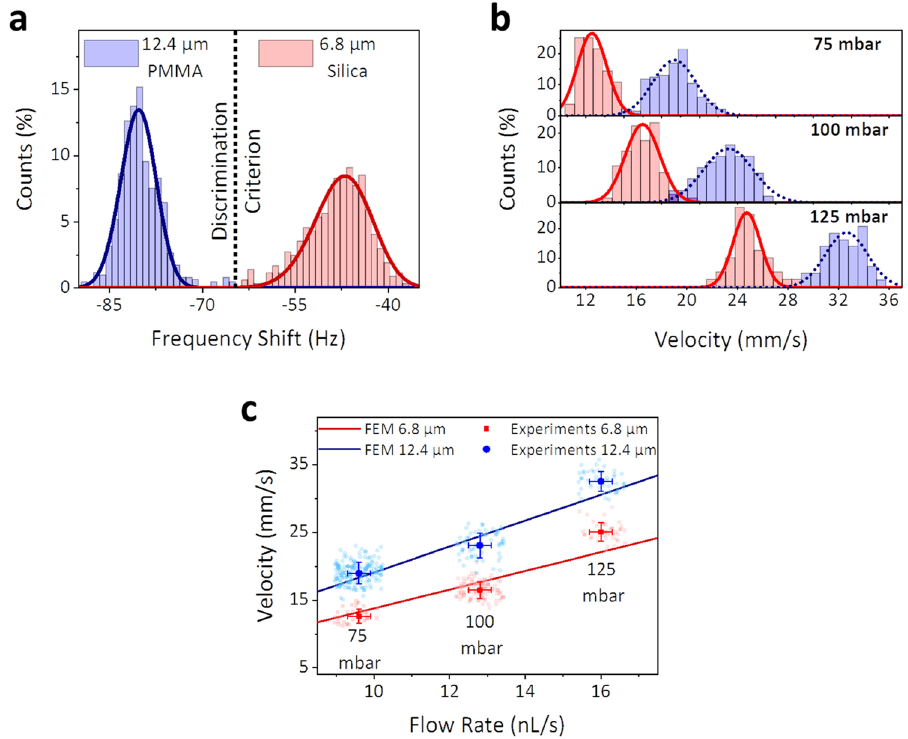
Figure 3. Experiments with particle mixtures . ( a ) Frequency spectra for the particle mixture (bars) and fits to gaussian distributions (solid lines). We set -65 Hz as discrimination criterion between two particle populations. ( b ) Experimental histograms of measured velocity for all particles for 3 differential pressures. ( c ) Experimental data (points) and FEM simulations (solid lines) of the particle velocity as a function of the applied flow rate for the PMMA particles (blue) and silica particles